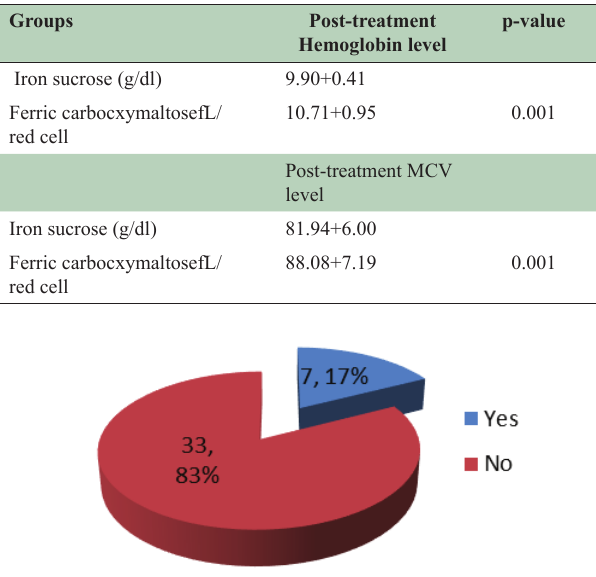
Table-III: Post-treatment hemoglobin level and meancorpuscular volume level comparing both groups.